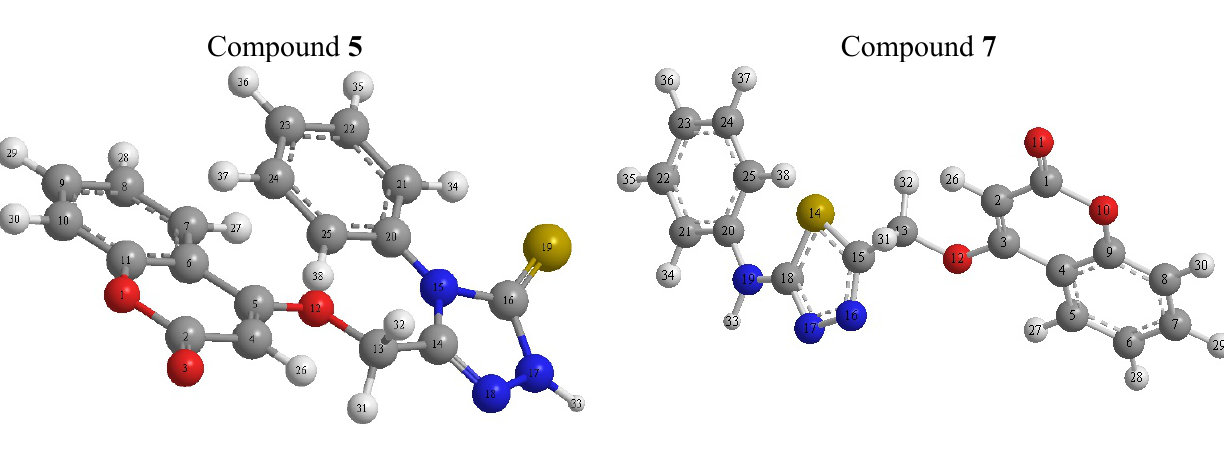
Figure 1. 3D-geometrical structures for compounds 5 and 7